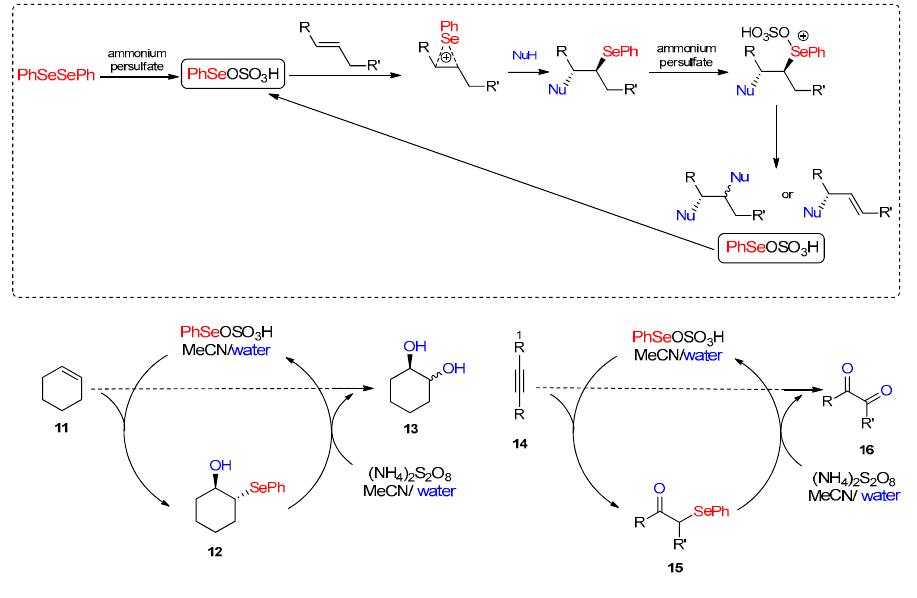
Figure 12. One-pot catalytic dihydroxylations.